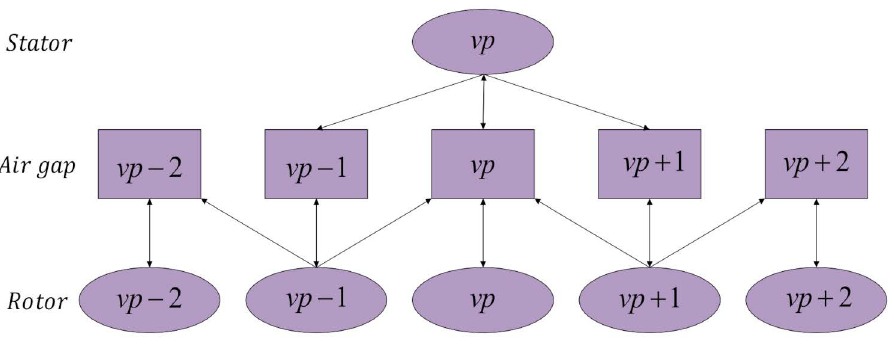
Figure 6. Motor magnetic field